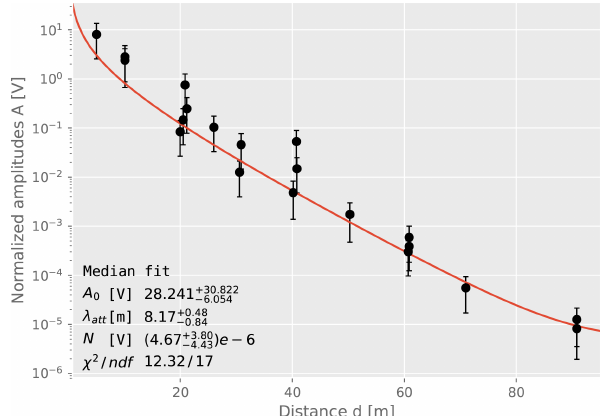
Figure 13. Fit of attenuation length λ att for 16kHz. The line and the χ 2 are calculated with the median parameters from the 1000 bootstrap estimates.